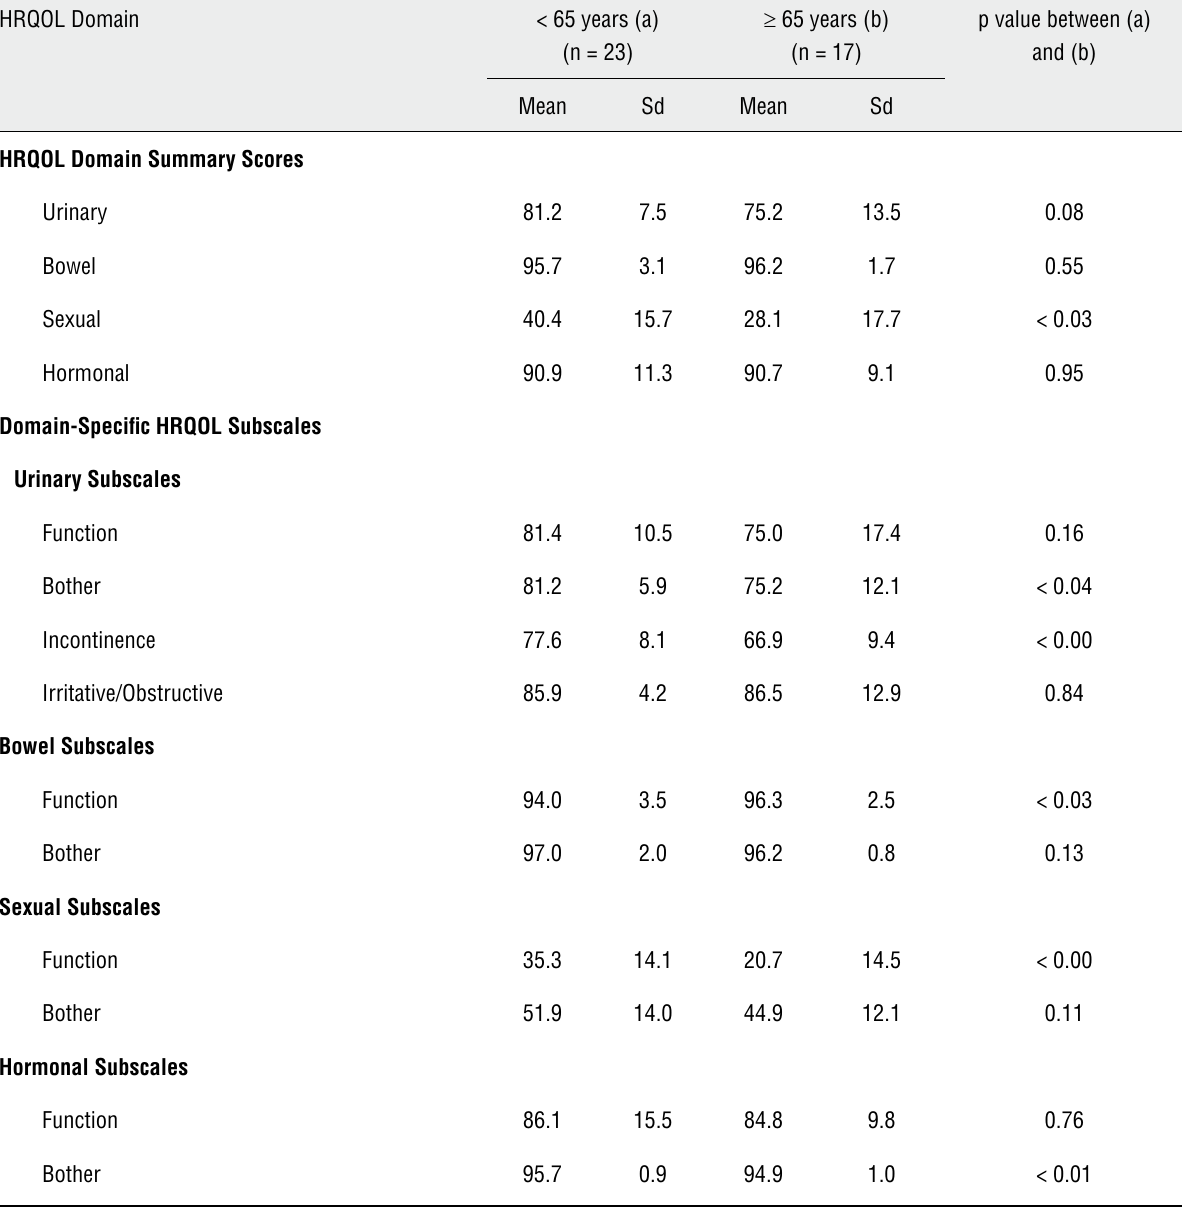
Table 4 - Correlation of EPIC score and age. HRQOL